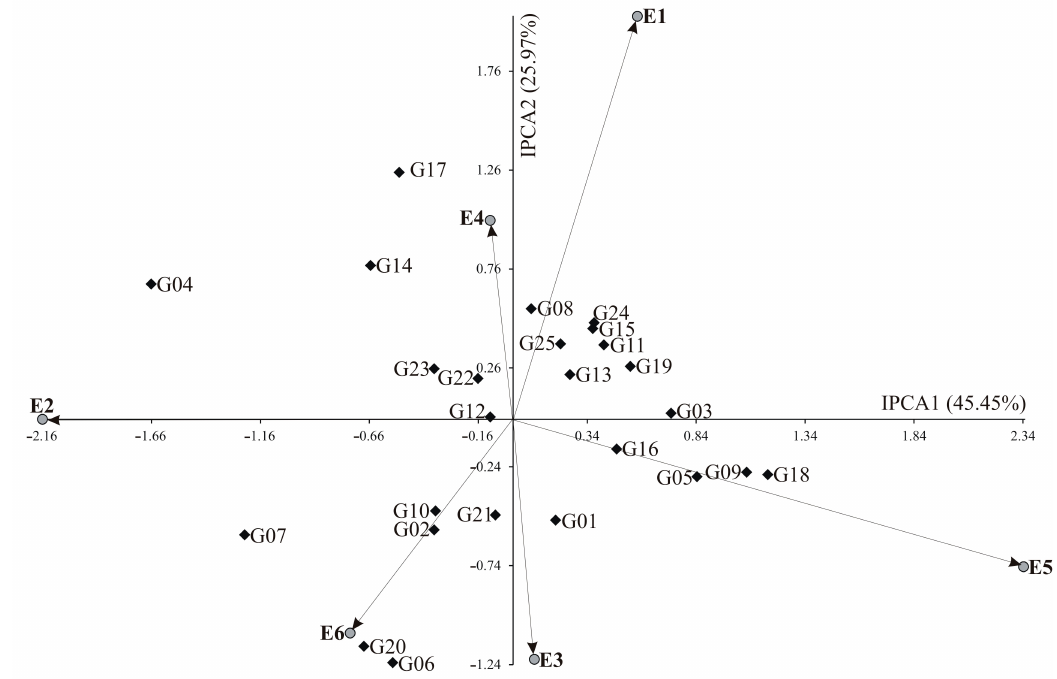
Figure 3. Biplot for genotype by environment interaction of C18:1 content in 25 winter oilseed rape ( B. napus ) genotypes in six environments, showing the effects of primary and secondary components (IPCA 1 and IPCA 2, respectively) (E1—Borowo, 2015; E2—Borowo, 2016; E3—Borowo, 2017; E4— Ł agiewniki, 2015; E5— Ł agiewniki, 2016; E6— Ł agiewniki, 2017).